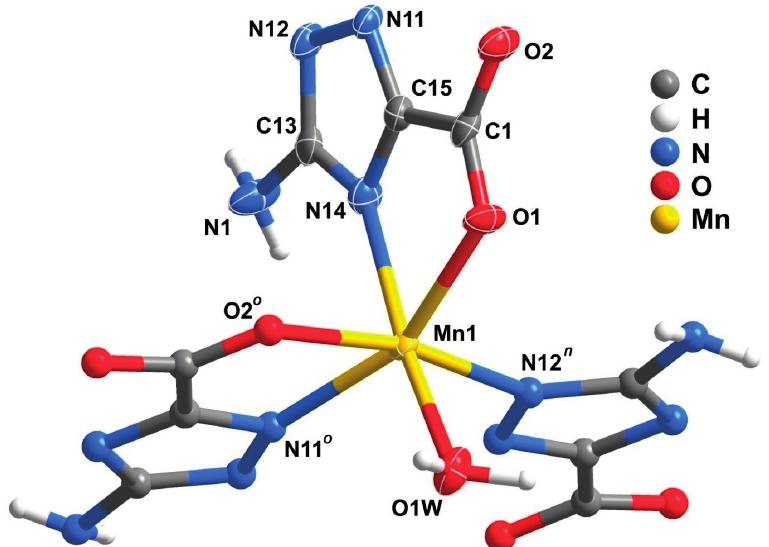
Figure 9. Mixed ellipsoid and ball-and-stick representation of the Mn 2+ coordination environment present in compound [Mn(atrc)(H 2 O)]·H 2 O ( 5 ), showing the labeling scheme for all non-H atoms composing the asu and the first metal coordination sphere. Non-H atoms of the asu are represented as thermal ellipsoids drawn at the 90% probability level and the remaining atoms as spheres with arbitrary radius. For selected bond lengths and angles see Table 3. Symmetry operations: n = − x , 0.5+y , 0.5 − z ; o = x , 0.5 − y , − 0.5+z